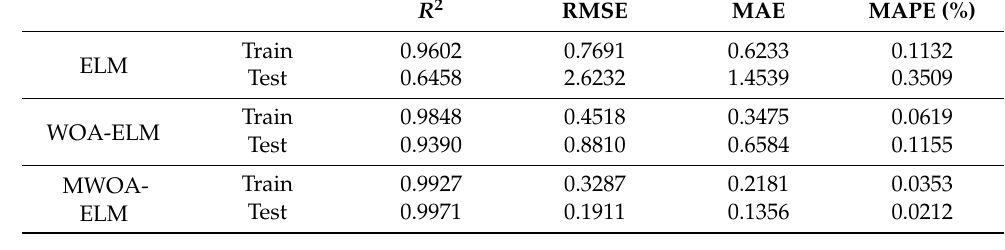
Table 3. Average of evaluation indicators for three ELM models.